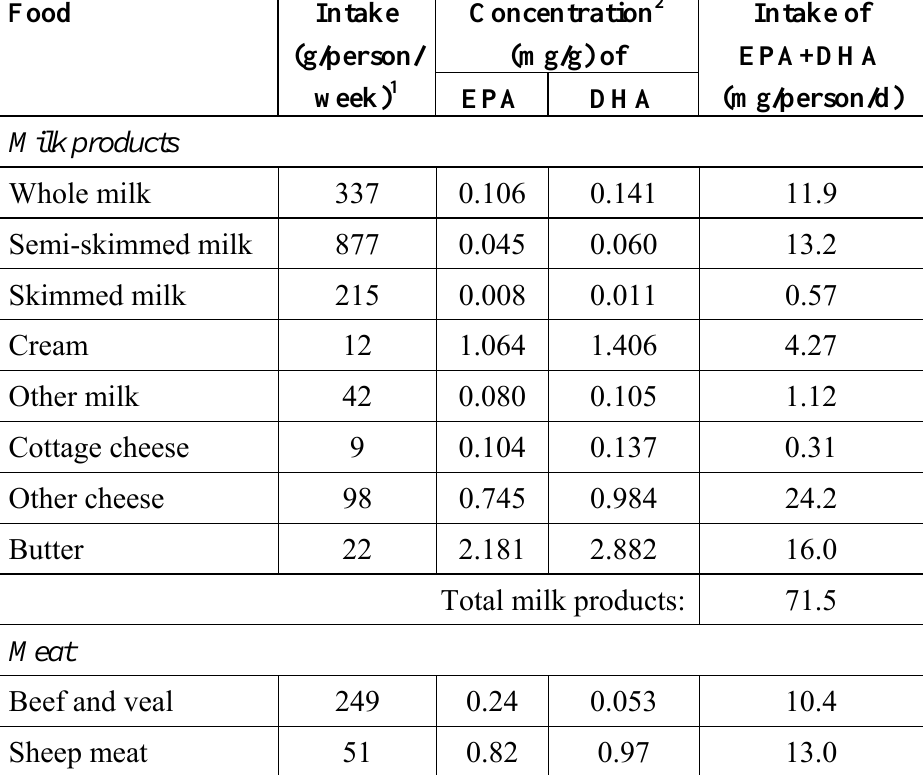
Table 4. Potential mean intakes of EPA and DHA by adults in the UK from enriched animal-derived foods (from